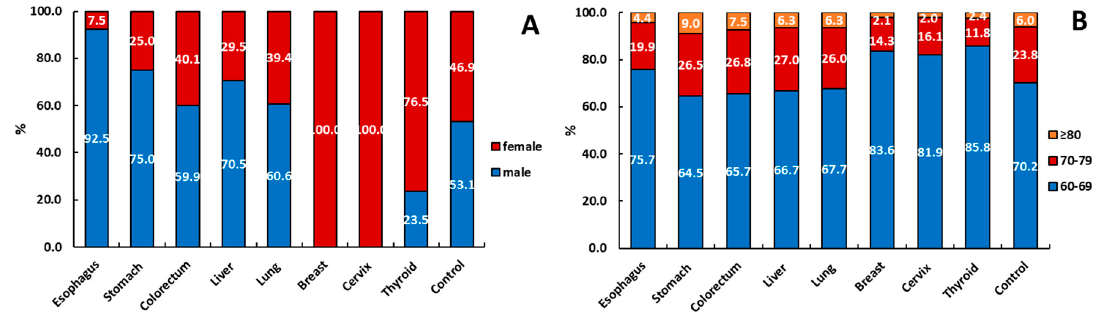
Figure 1. The age and gender distribution in the cancer and non-cancer study groups. ( A ) Gender distribution; ( B ) age distribution.